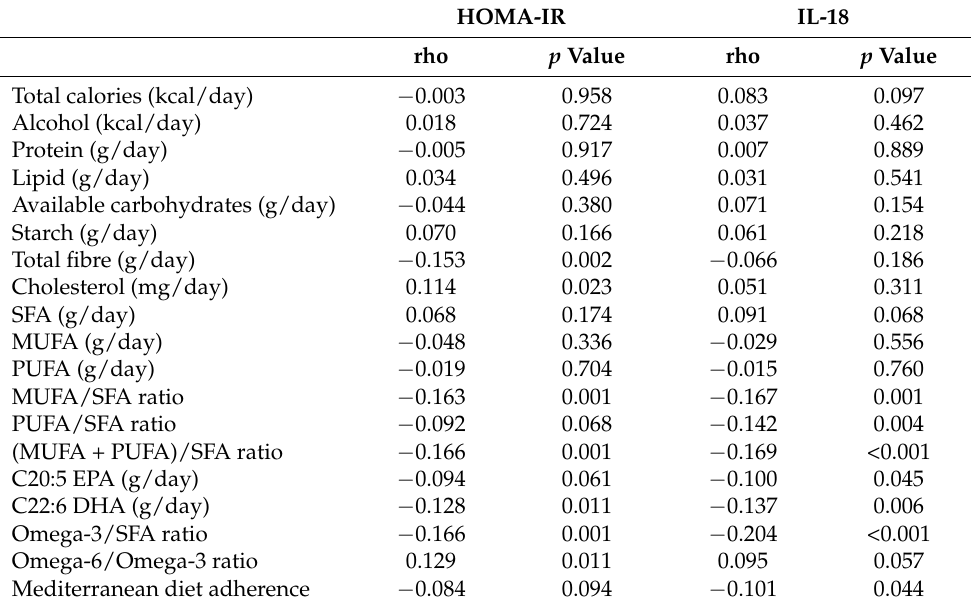
Table 3. Spearman’s rho correlation between Il-18 and dietary